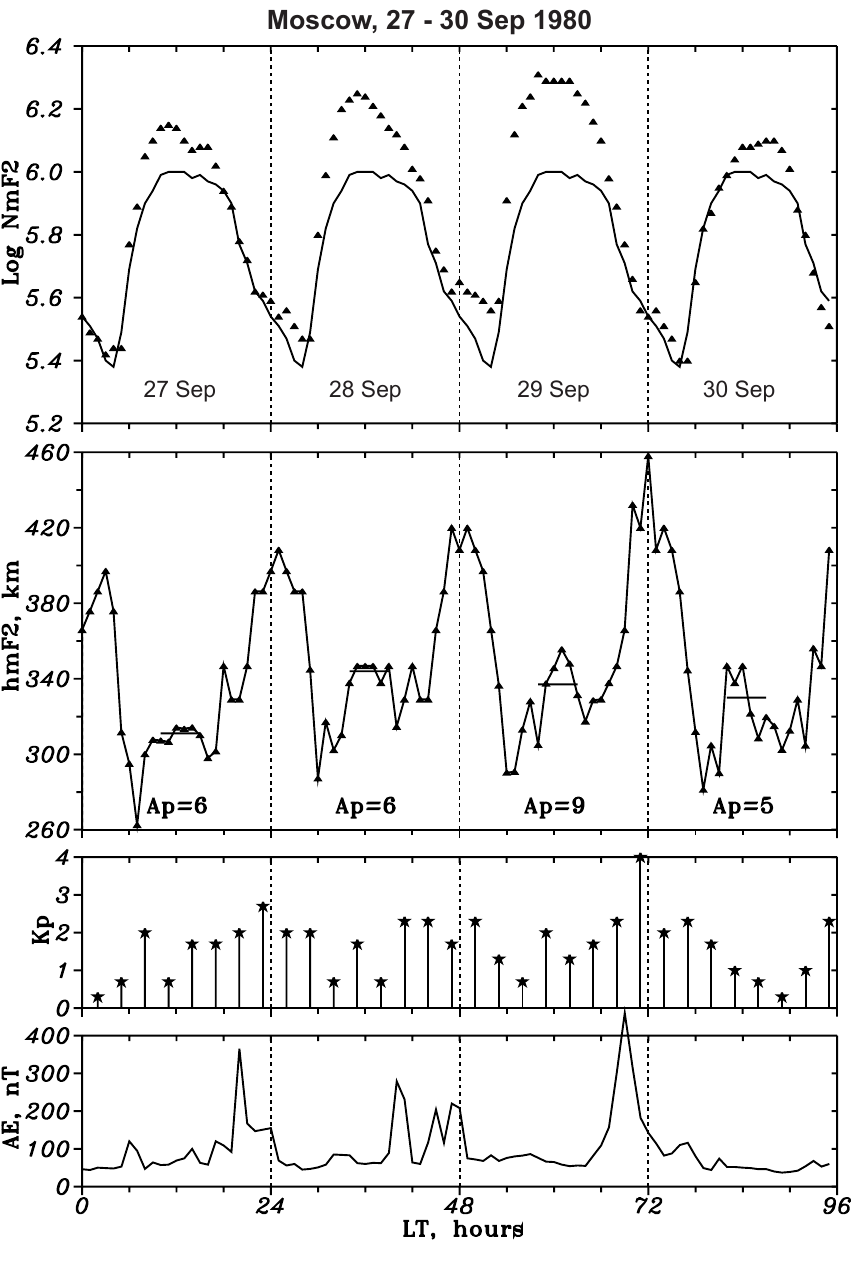
Fig. 2. An example of strong pos- itive quiet-time NmF2 deviations ob- served at Moscow in September 1980. Monthly median NmF2 is shown as solid line (top panel). Diurnal varia- tions of hm F2 inferred from M(3000)F2 parameter are shown in the second panel. Averages of hm F2 from 10–15 LT are shown as horizontal thin lines. Daily Ap , 3-hour Kp and hourly AE in- dices are shown in the third and fourth